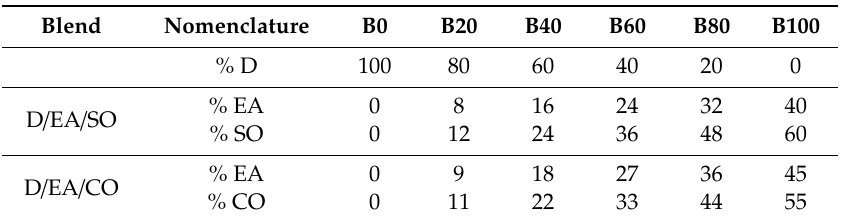
Figure 1. Scheme of experimental methodology. Table 2. Diesel/ethyl acetate/sunflower oil blends containing 40% ethyl acetate, and diesel/ethyl acetate/castor oil blends containing 45% ethyl acetate.